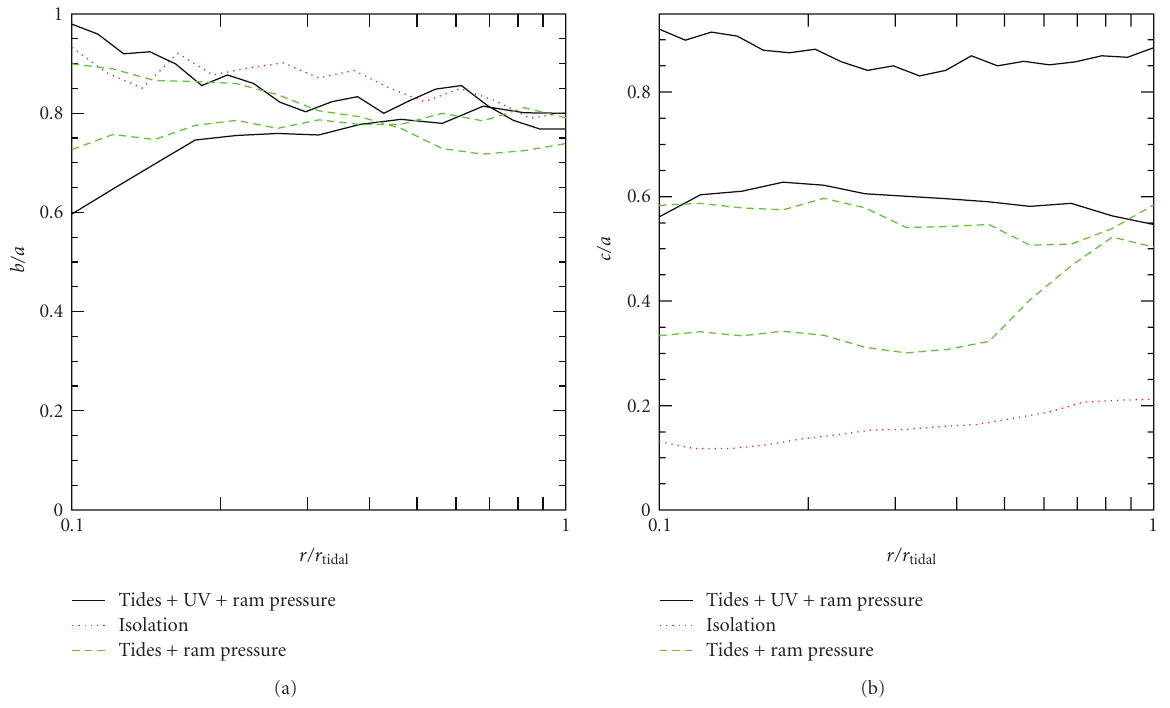
Figure 7: Shape evolution of the stellar component. The upper panel shows the intermediate-to-major axis ratio, b/a , and the bottom panel presents the minor-to-major axis ratio, c/a . Solid lines correspond to the self-consistent simulation in which tides, ram pressure stripping, and UV background were included throughout the orbital evolution of the dwarf. Dotted lines correspond to the case where the dwarf galaxy was extracted from the simulation just after the gas was removed and evolved in isolation. Dashed lines show results of a test in which approximately 30% of the initial gas mass remains in the galaxy because the absence of the UV background reduces significantly the e ff ectiveness of ram pressure stripping. Thick and thin lines correspond to 10 and 5 Gyr of orbital evolution, respectively (for the extracted dwarf we only show the result after 10Gyr). The shape of the stellar component changes gradually over time and the presence of UV heating is essential for the shape transformation of